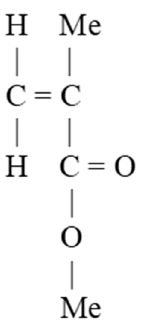
Figure 1. Methylmethacrylate molecular structure (Me stands for -CH 3).